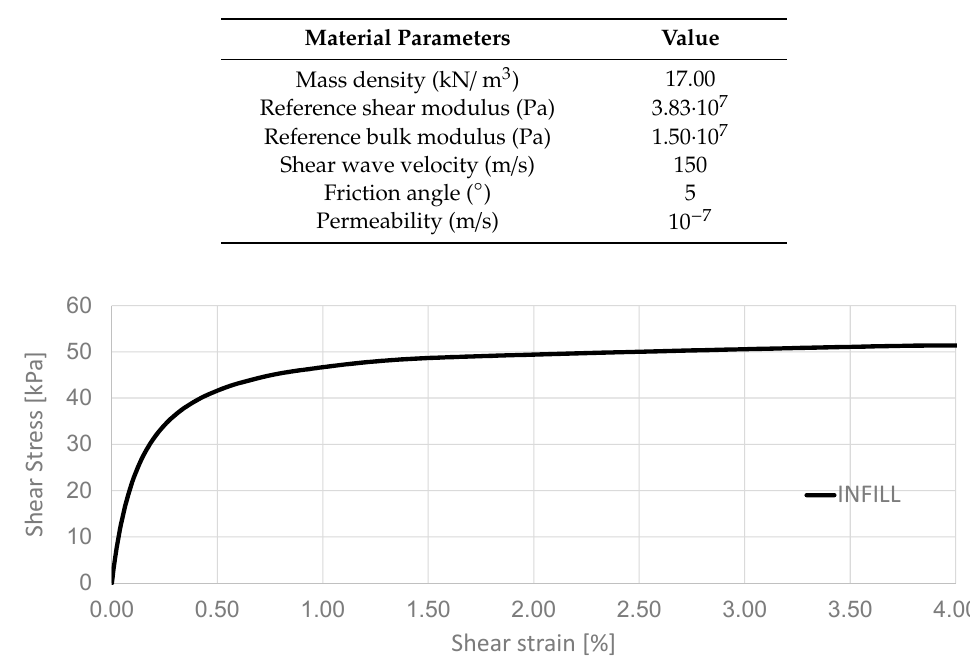
Figure 5. Backbone curve of the infill soil. Table 7. Material parameters (infill soil).